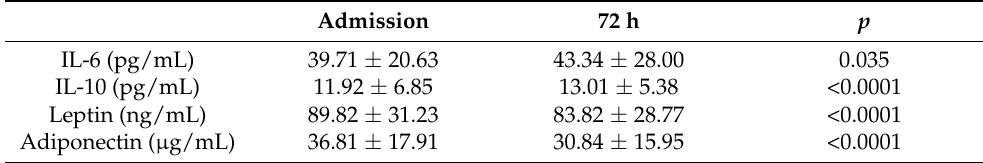
Table 4. Concentrations of biomarkers on admission and at 72 h.